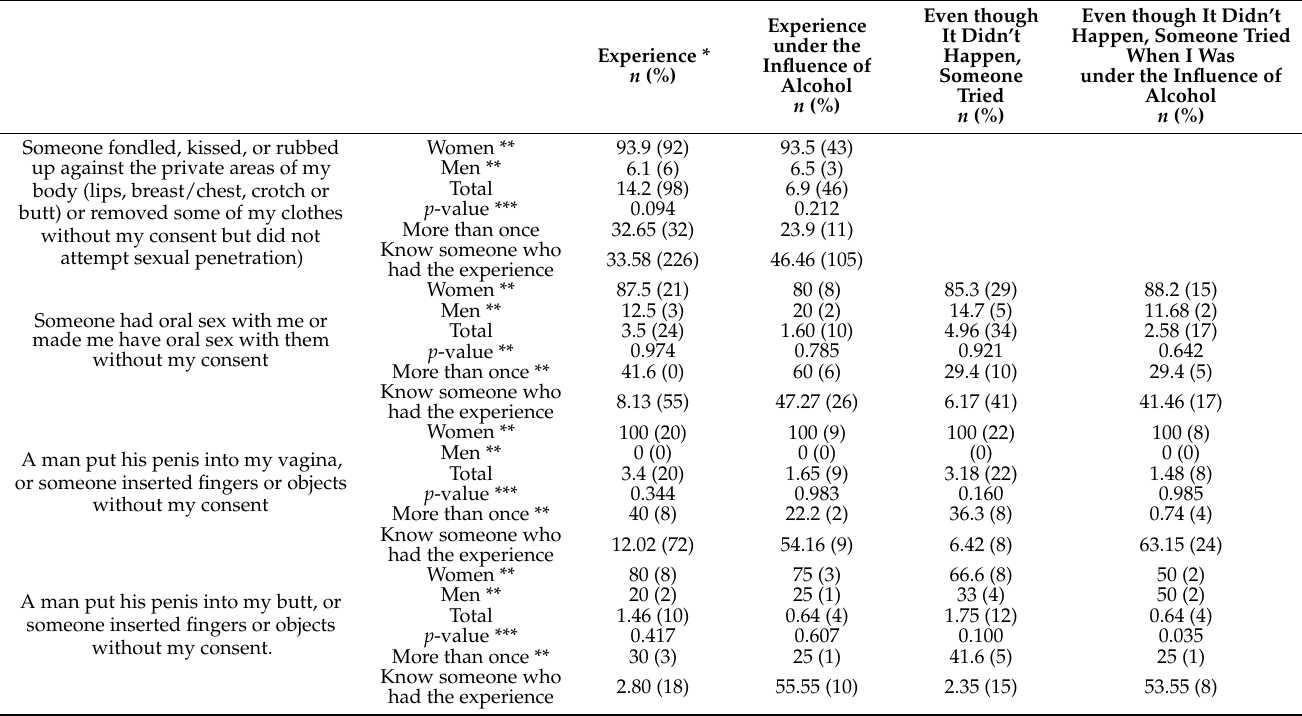
Table 3. Prevalence of sexual violence by gender ( n =